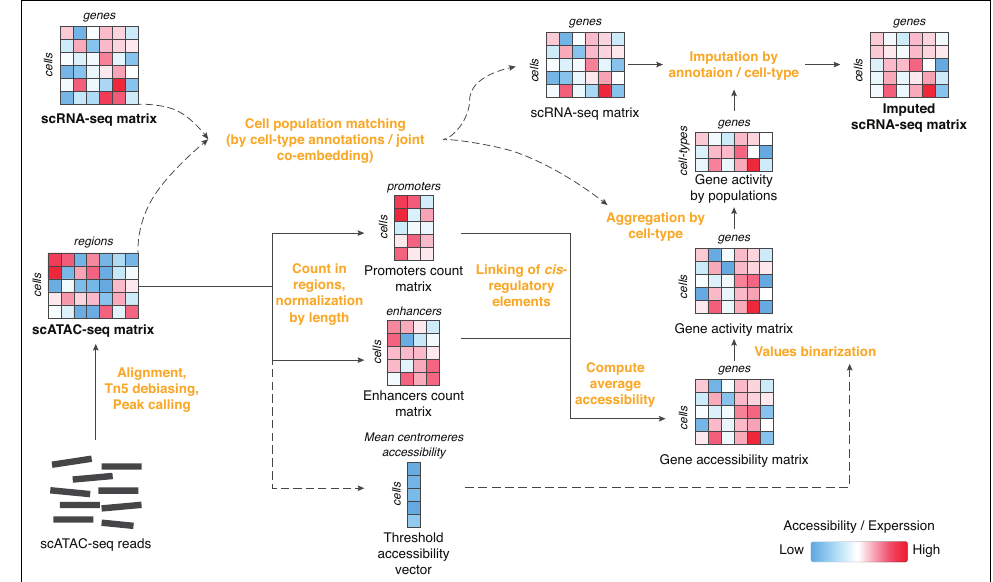
Figure 1. An overview of the Epi-Impute pipeline. Data processing steps are highlighted in orange. Average accessibility in centromeres regions from ENCODE Blacklist [21] was used to create a Threshold accessibility vector to assess signal-to-noise ratio of chromatin